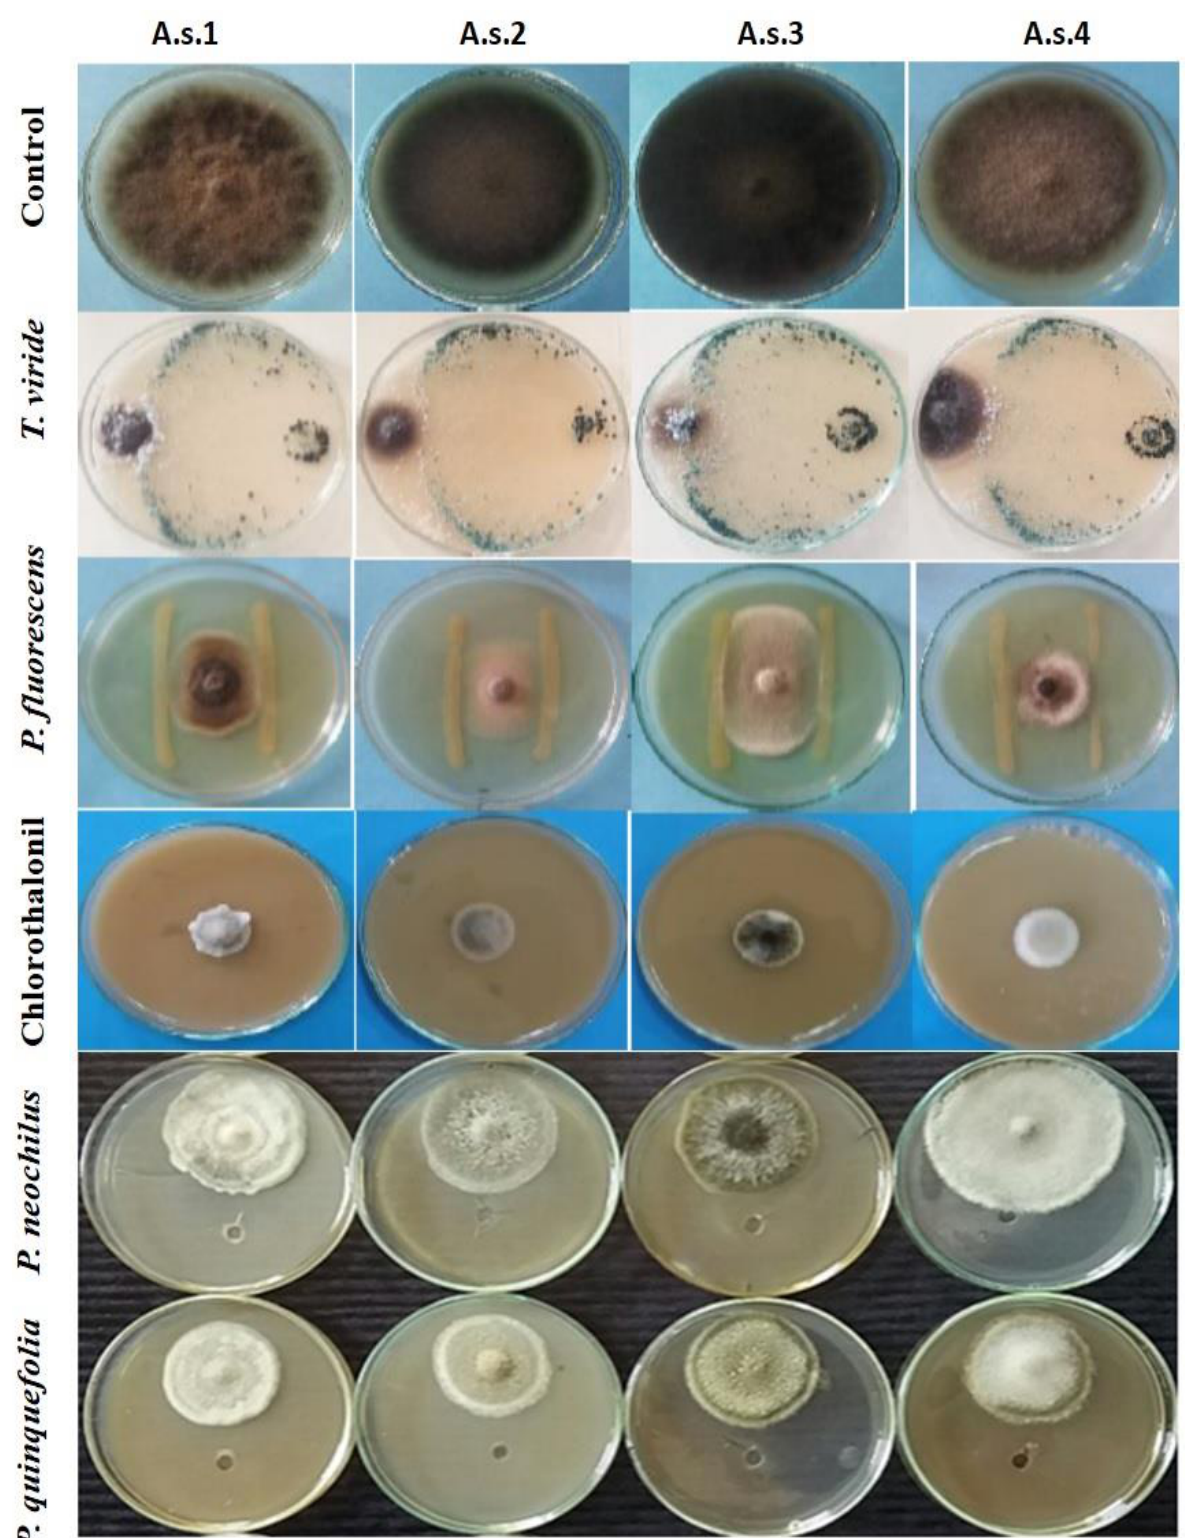
Figure 5. Antagonistic activity of bioagents ( T. viride , P. fluorescens ), Chlorothalonil fungicide at concentration 625 mg/L, P. neochilus and P. quinquefolia extracts at concentration of 2500 mg/L against A. solani compared to the control in vitro.